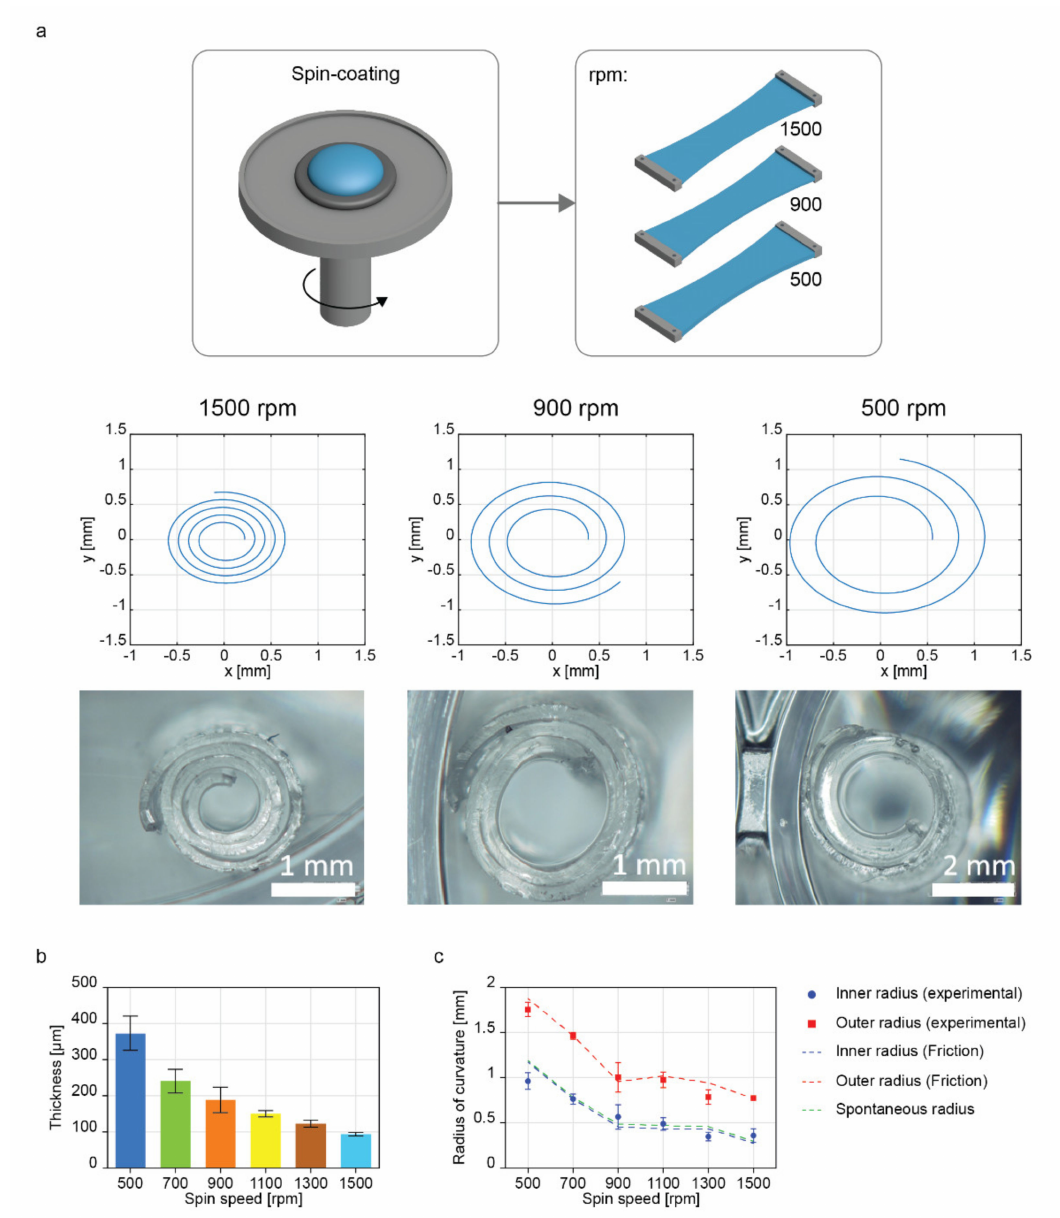
Figure 3. Bilayer fabrication and model validation at different thickness values. ( a ) Schematic representing the fabricated films having different thickness values by varying the spin coating speed (from 500 to 1500), representative images of model-derived spirals, and microscope images of bilayers fabricated at different spin coating velocities. ( b ) Analysis of the bilayer thickness at different spin coating speeds (from 500 to 1500 rpm). ( c ) Comparative plot between experimental data and model predictions for rolled bilayers at different thickness values under the high friction